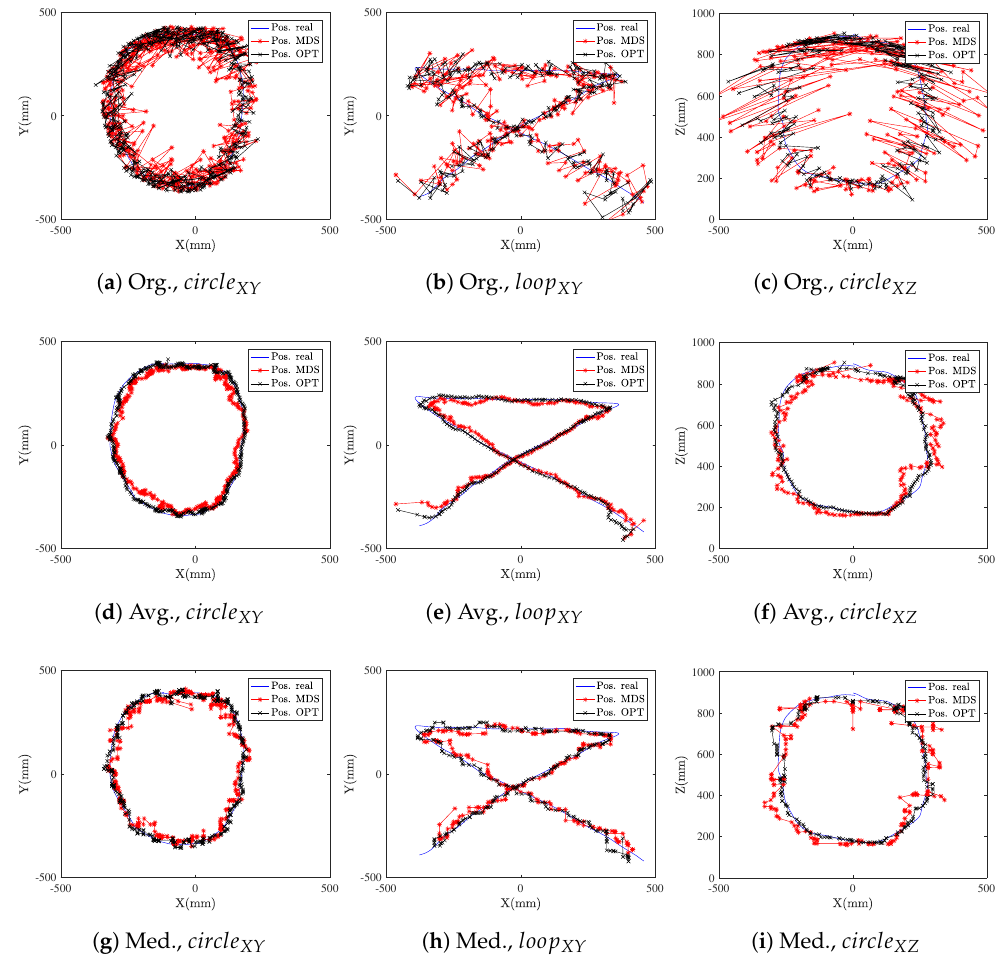
Figure 9. Comparison between the real and estimated trajectories for SMACOF MDS (MDS) and LM-BFGS optimization (OPT) algorithms for the three different gestures, with a fixed noise level ( σ = 10 mm), without smoothing (sub-figures a – c ), with moving-average (Avg.) smoothing (sub- figures d – f ) and with moving-median (Med.) smoothing (sub-figures g – i